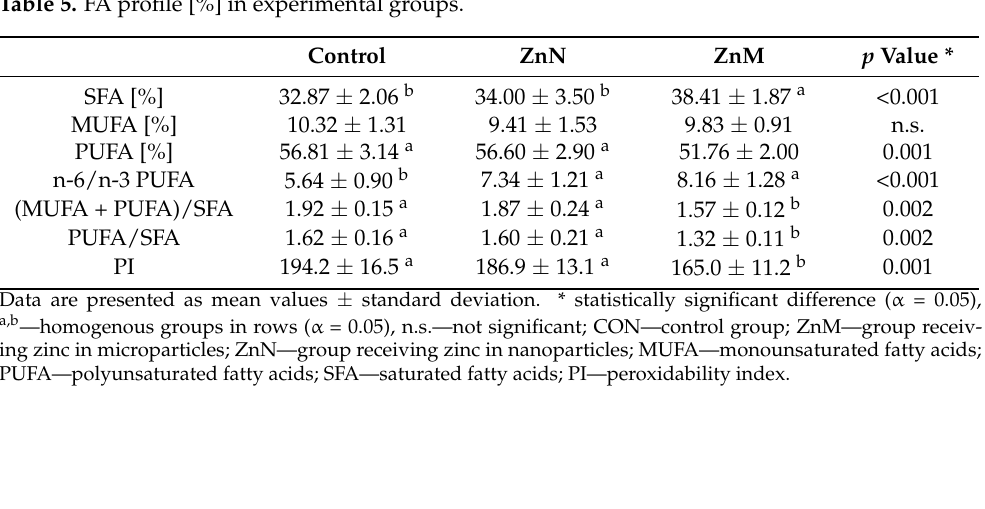
Table 5. FA profile [%] in experimental groups.